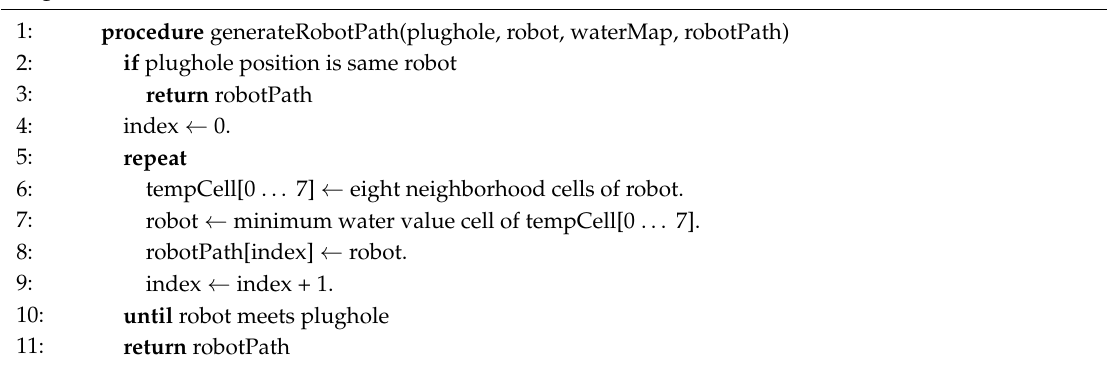
Algorithm 2. RobotPathGeneration